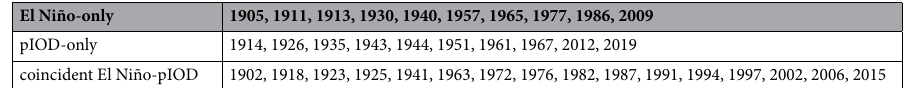
El Niño-only pIOD-only coincident El Table 3. The year of El Niño-only, pIOD-only, and coincident El Niño-pIOD events during 1900–2019.